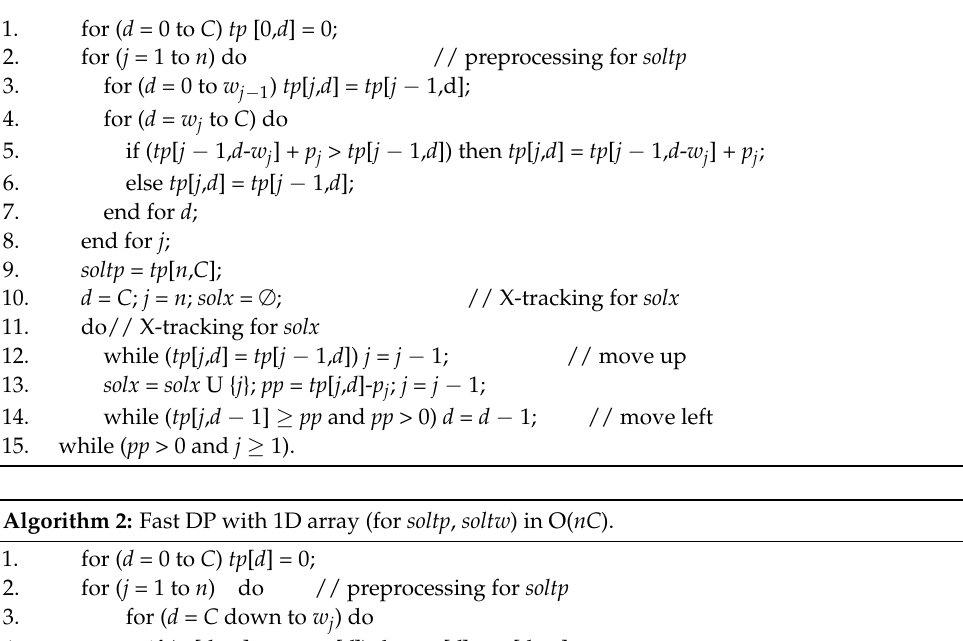
Algorithm 1: Basic DP with 2D array (for soltp , soltw , solx [ n ]) in O( nC ).